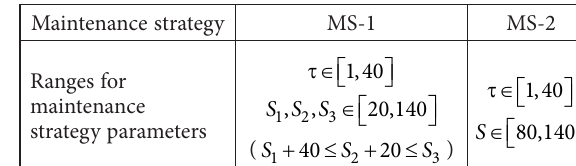
Table 7. Strategies to be optimized and ranges for their